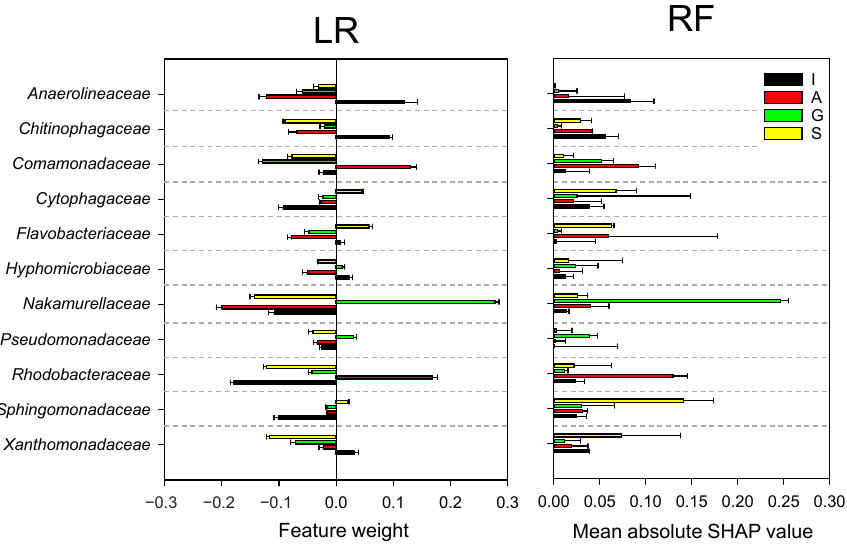
Figure 6. Feature weights and mean absolute SHAP impact values of the major families.